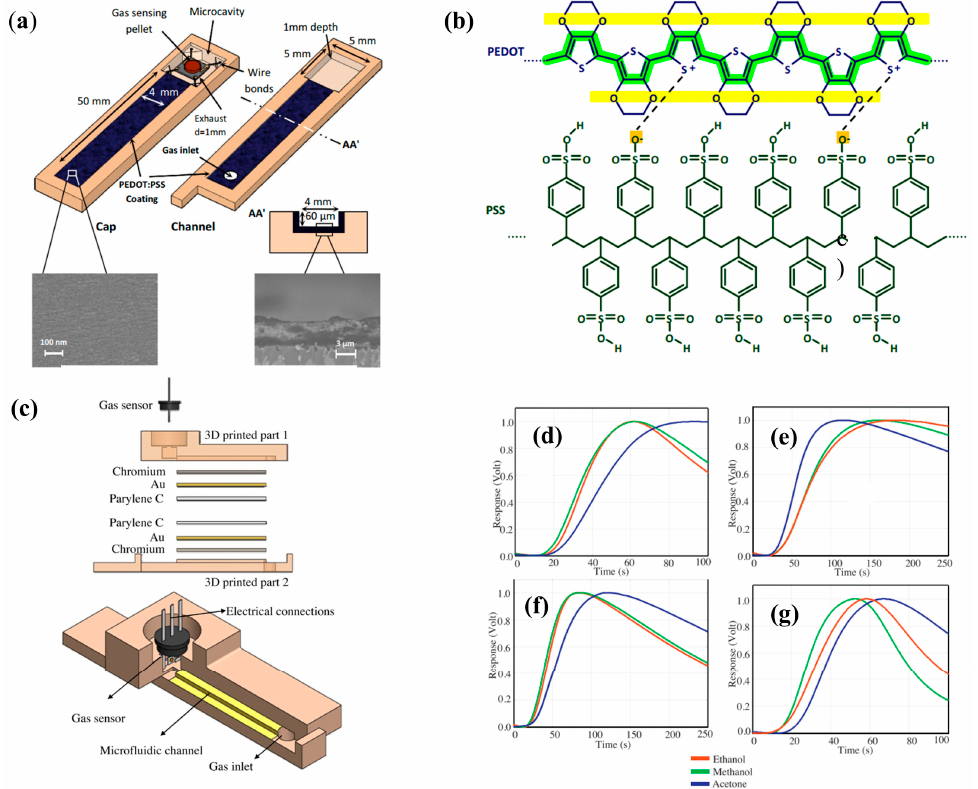
Figure 2. Device architecture, structure of PEDOT:PSS, normalized responses. ( a ) Scheme of the PEDOT:PSS-coated microfluidic channel integrated with a gas sensor. ( b ) Macromolecular